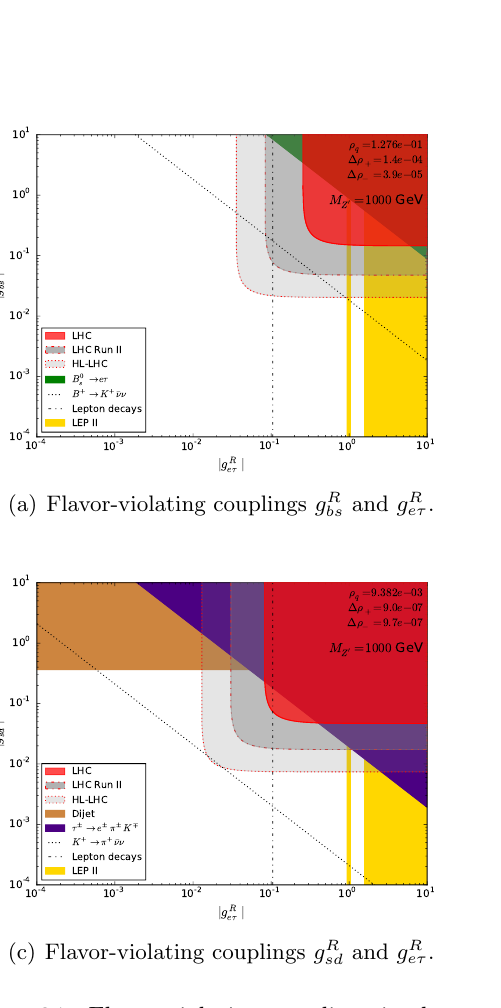
Figure 21 . Flavor-violating couplings in the e(cid:28) sector for a Z 0 boson of M Z 0 = 1 TeV. The red p areas depict the limits from the ATLAS analysis of the process pp ! e(cid:28) at s = 8 TeV. The red dash-dotted and dashed lines are projections to the LHC Run II and HL-LHC. The brown areas show four-quark contact interaction limits from LHC dijet analyses [15]. The green areas are the limits coming from meson decays into charged leptons. In purple we show the bounds from the rare decay (cid:28) (cid:0) ! e (cid:0) (cid:25) + K (cid:0) only applicable in the sd sector. The gold areas are purely leptonic limits coming from LEP constraints. The black dotted lines are meson decay limits into neutrinos and the black dash-dotted line the limits from lepton decays. These last two limits, however, apply only for left-handed lepton couplings g L instead of g R . The meson decay limits into neutrinos are absent e(cid:28) e(cid:28) in the cu sector